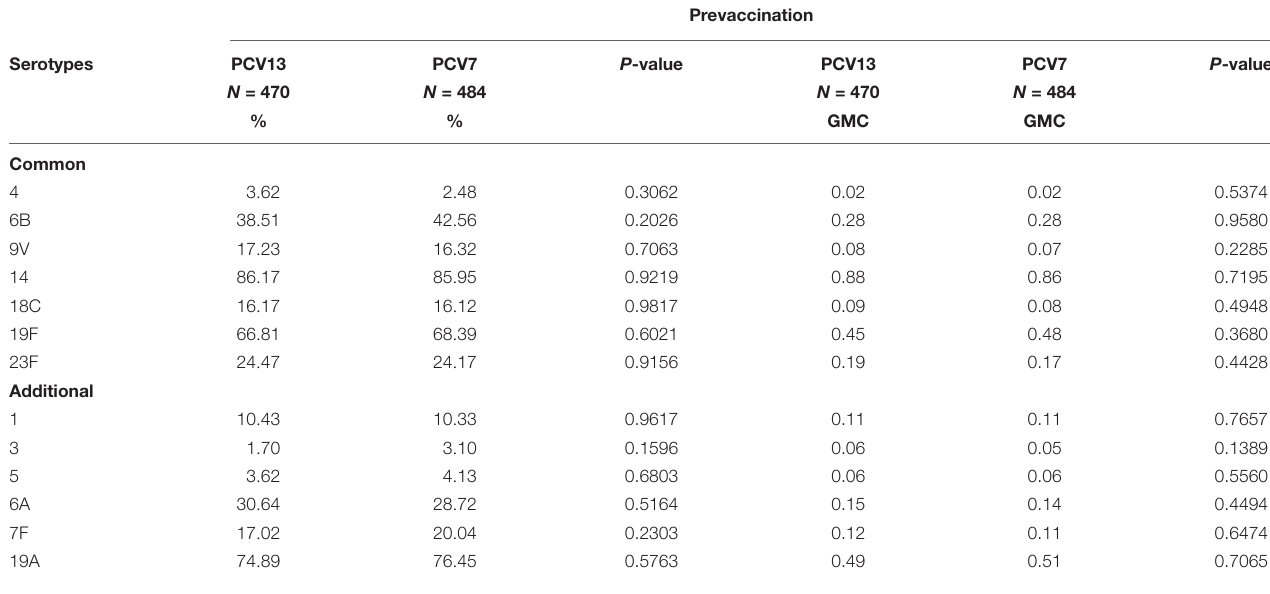
TABLE 2 | Subjects’ antibody-positive rate and geometric mean concentration (GMC) of the pneumococcal capsular IgG levels at